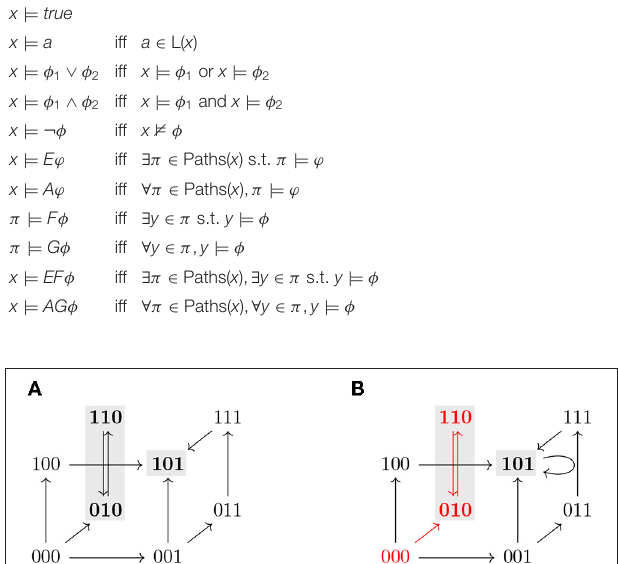
TABLE 1 | Satisfaction relation and semantics for the CTL formulas used in this work, with a ∈ AP an atomic proposition, x ∈ S a state, π a path in the transition system, ϕ a path formula and φ , φ 1 , and φ 2 state formulas.